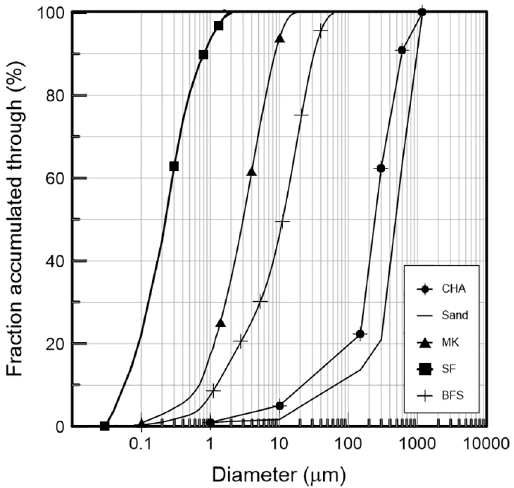
Figure 1. Particle size distribution curves of: MK, SF, BFS, sand and chamotte.